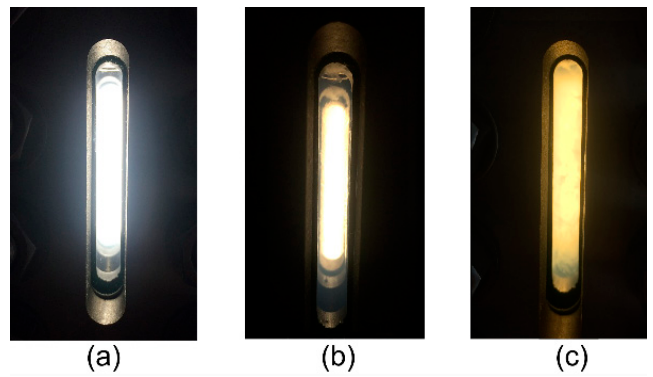
Figure 1. The phase transitions of supercritical CO 2 –polymer system under constant temperature, ( a ) single phase (above cloud point); ( b ) the appearance of the mist (cloud point); and ( c ) two phase (below cloud point) .